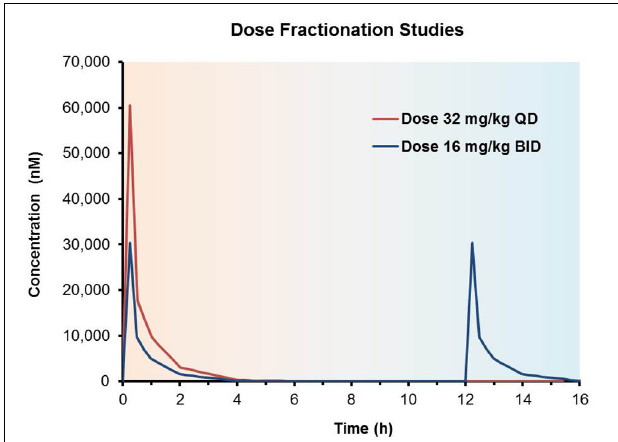
FIGURE 6 | Dose fractionation studies to determine the pharmacokinetic driver. Impact of once daily (QD) vs. twice daily (BID) dosing regimens of the same total daily dose; both doses yield identical overall AUC 0 − 24h values but different C max concentrations over the course of the dosing